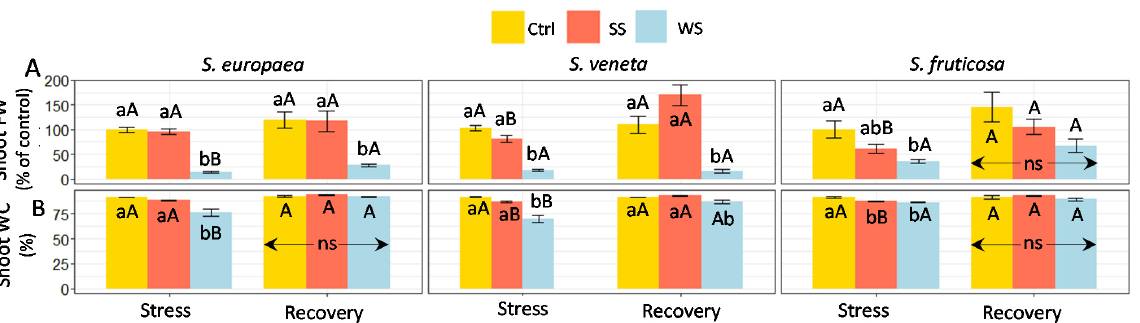
Figure 2. Effect of 30 days of stress treatments (Stress), followed by watering with non-saline water for 15 days (Recovery) on ( A ) shoot fresh weight (FW) and ( B ) shoot water content (SWC) in the three halophytes. Ctrl, control; SS, salt stress (watering with 700 mM NaCl); WS, water stress (complete withholding of irrigation). For each species and sampling (Stress or Recovery), different lowercase letters over the bars indicate significant differences between treatments (Ctrl, SS, and WS), whereas different uppercase letters indicate significant differences between the two samplings (Stress and Recovery) for each species and treatment, at p ≤ 0.05. Vertical bars indicate standard error ( n = 4). Values in ( A ) are shown as percentages of shoot FW of control plants (Ctrl, Stress), taken as 100%; the corresponding absolute values for S. europaea , S. veneta , and S.fruticosa were 13.3, 10.1, and 5.6 g plant − 1 , respectively. ns: non-significant.